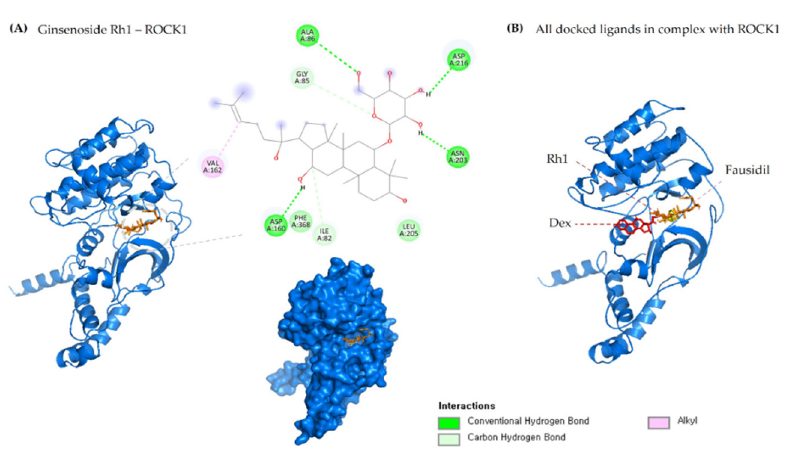
Figure 2 . ( A ) 2D & 3D docking interactions of Ginsenoside Rh1 with ROCK1. ( B ) All docked